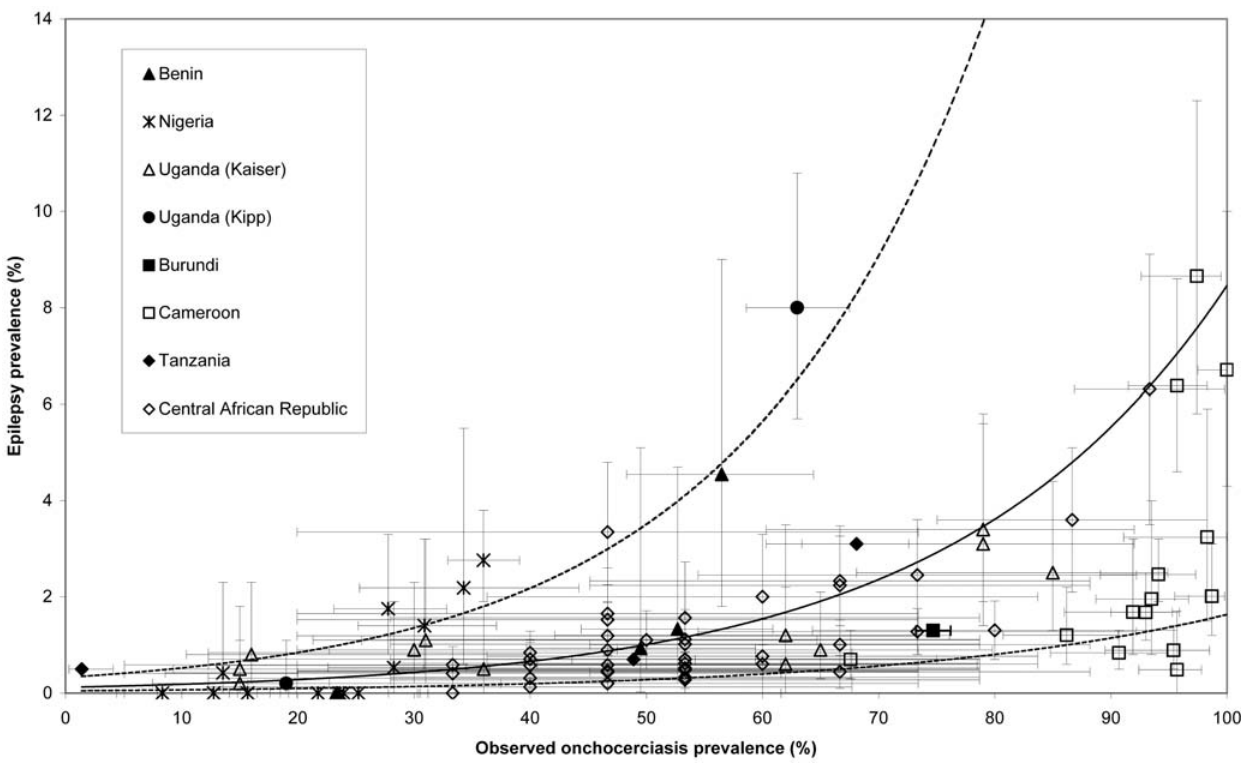
Figure 2. Epilepsy prevalence (as reported in the original studies) vs onchocerciasis prevalence. Error bars represent 95% exact confidence intervals. Solid line: predicted relationship estimated by random-effect logistic regression; dashed lines: 95% confidence interval of the model predictions.